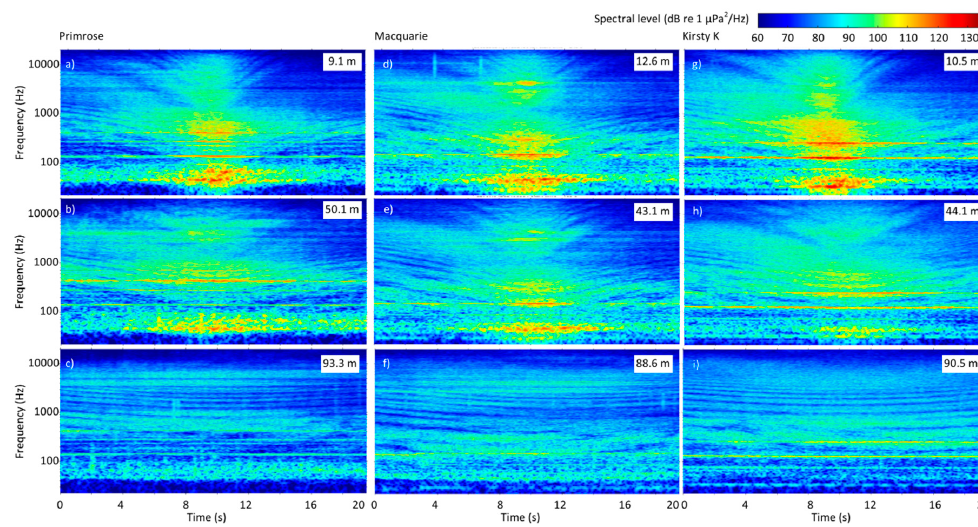
Figure 3. Spectrograms of 20 s recordings of individual passes of ( a – c ) Primrose , ( d – f ) Macquarie and ( g – i ) Kirsty K (all travelling at ≈ 30 km h − 1 ), as recorded almost directly ( a , d , g ) beneath the vessel ( ≈ 9 m range), ( b , e , h ) at the 25 m and ( c , f , i ) the ≈ 100 m ranges. CPA distance shown in top right of each spectrogram.